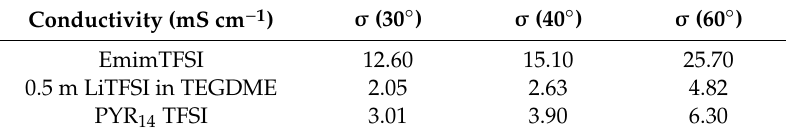
Figure 1. SEM images of electrospun membrane of ( a ) pullulan and ( b ) cellulose triacetate with their molecular structures. Table 2. Ionic conductivity of the tested electrolytes at di ff erent temperatures.